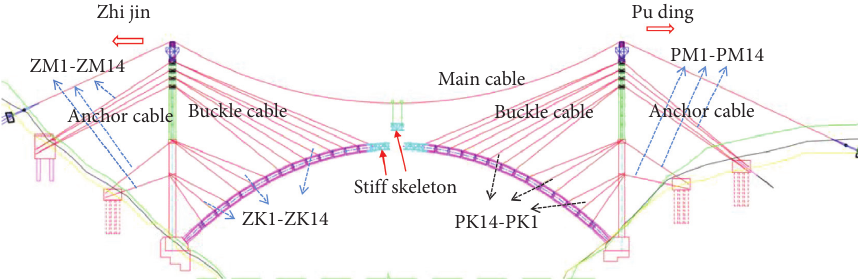
Figure 12: Install the stiff skeleton at the top of the arch ring of the Yelang Lake Bridge.